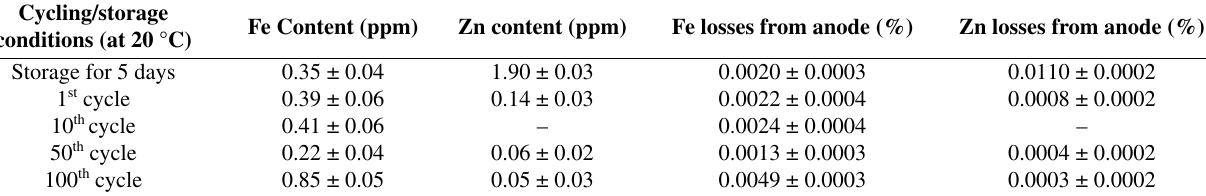
O ) is 0.02 mg cm –2 . 2 4